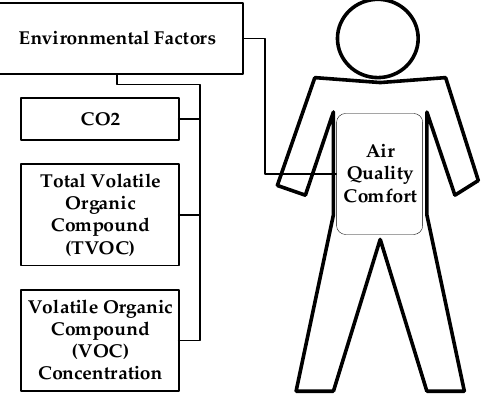
Figure 7. Categorization of different air quality comfort factors [131].